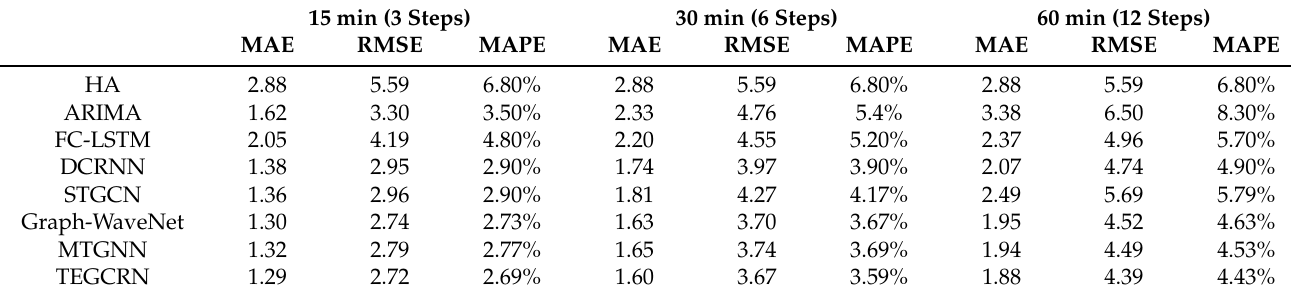
Table 4. Prediction Results of PEMS-BAY